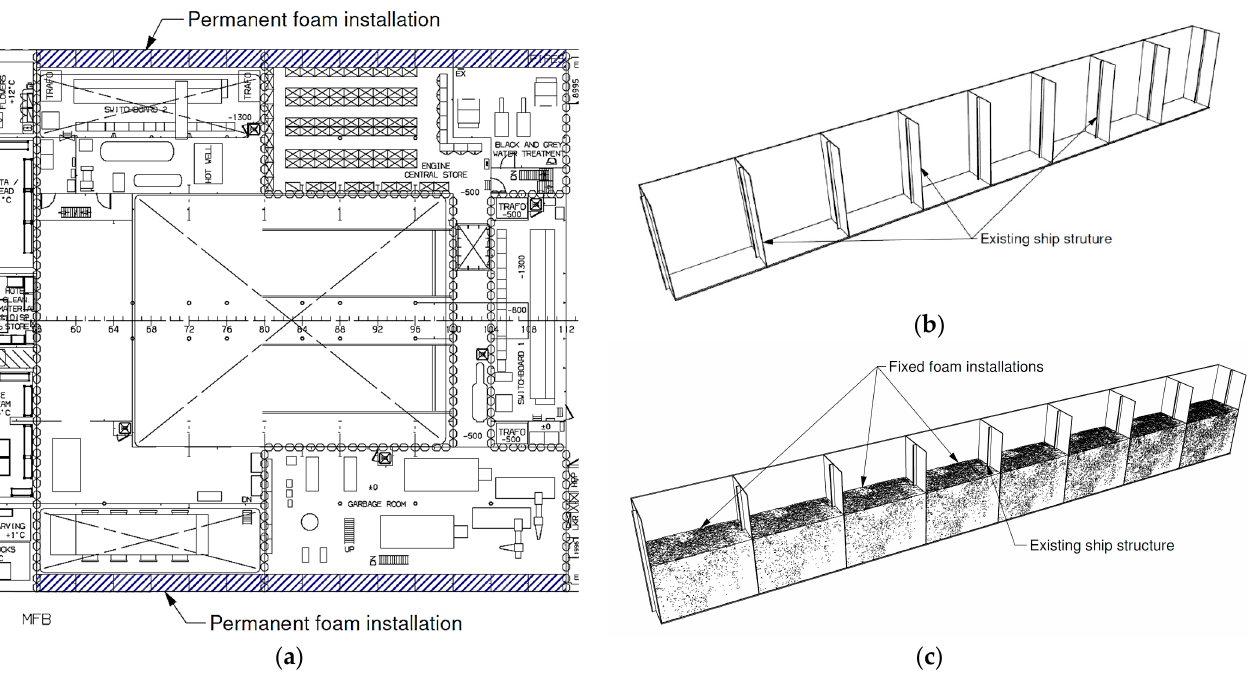
Figure 4. AREST P1 system; ( a ) permanent foam installation sites (blue) in a double hull. ( b ) Existing ship structures in the installation site. ( c ) Void spaces filled with